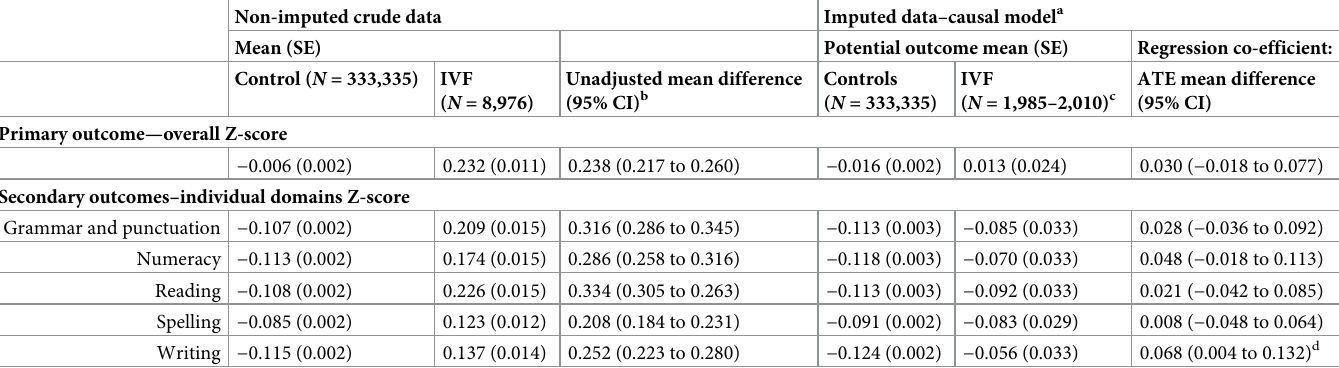
Table 4. Results of final causal